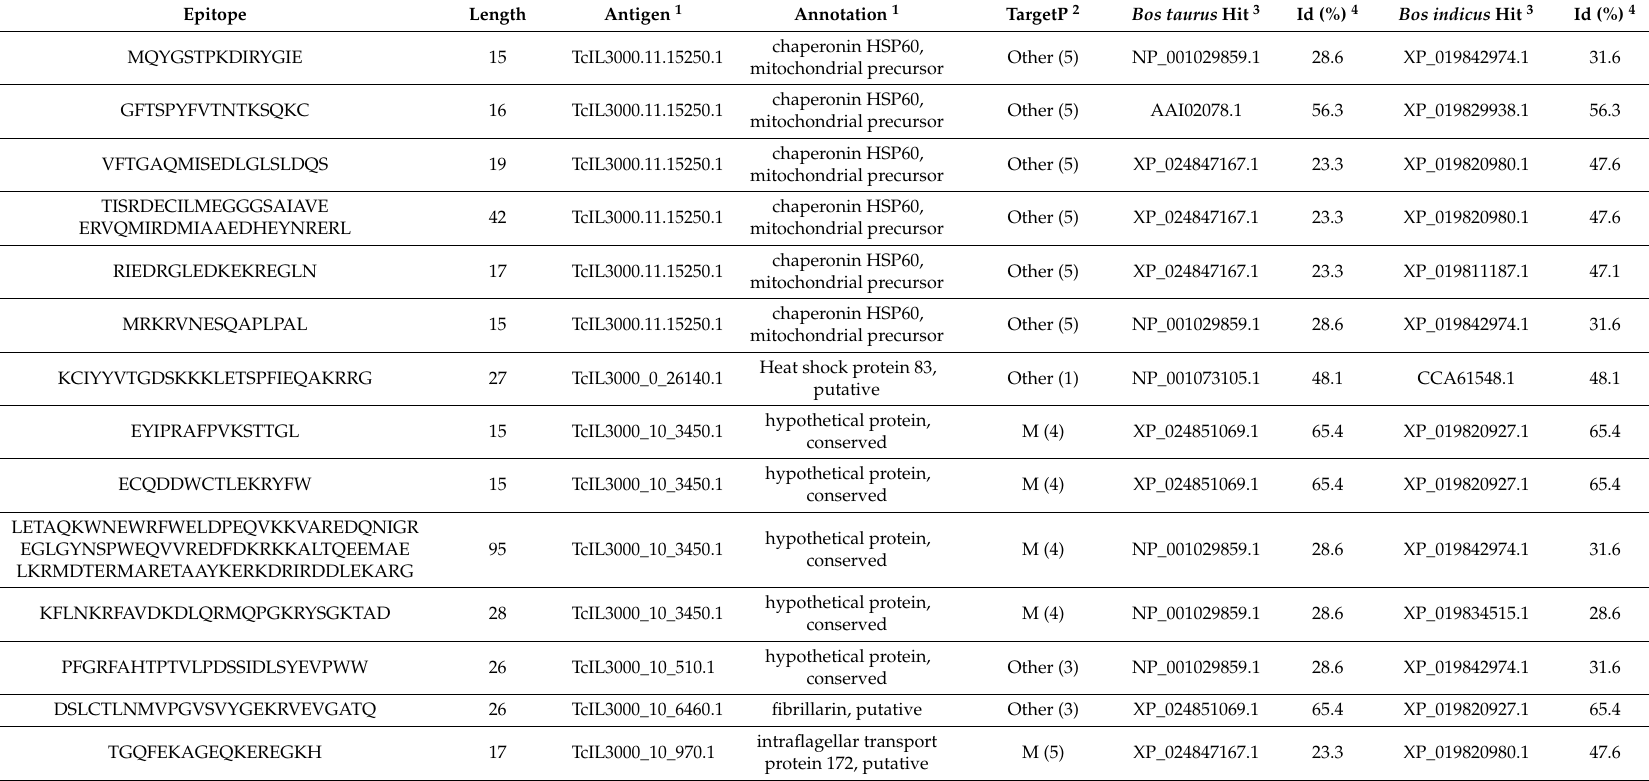
Table 1. List of the B-cell epitopes predicted in the invariant AAT-spp. proteome selected for the